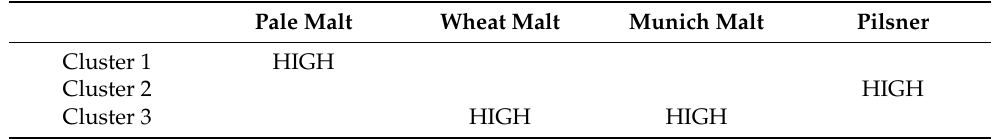
Table 7. Clusters’ distinct characteristics in Guinness Extra Stout, illustrating varying ingredient con- sumptions.